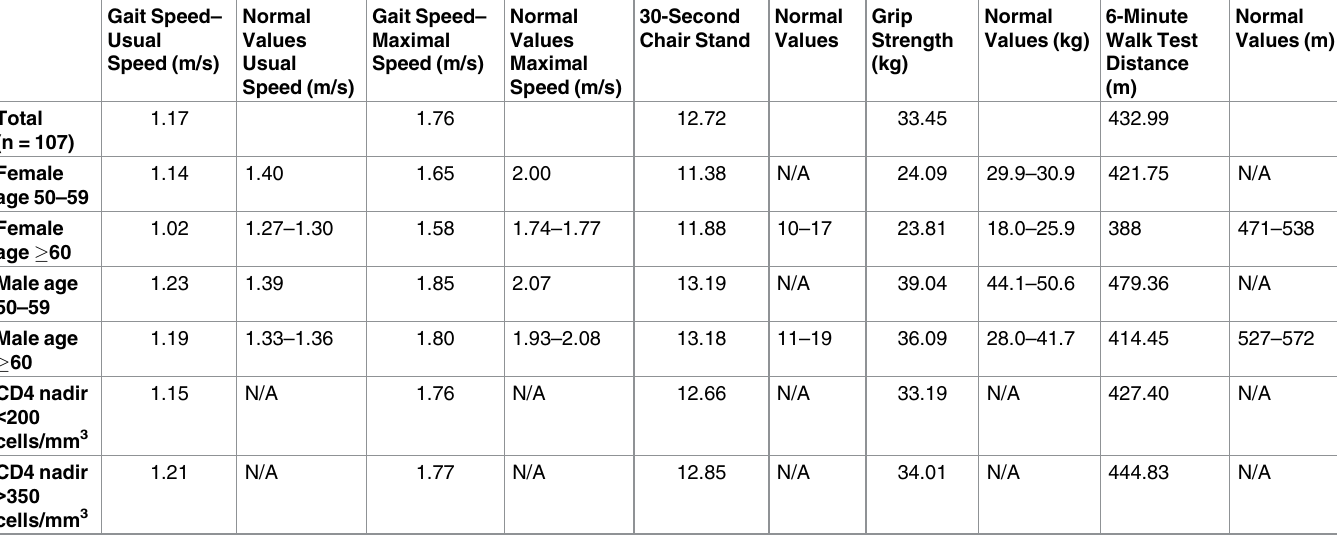
Table 3. Physical function compared to normal referencevalues ranges.